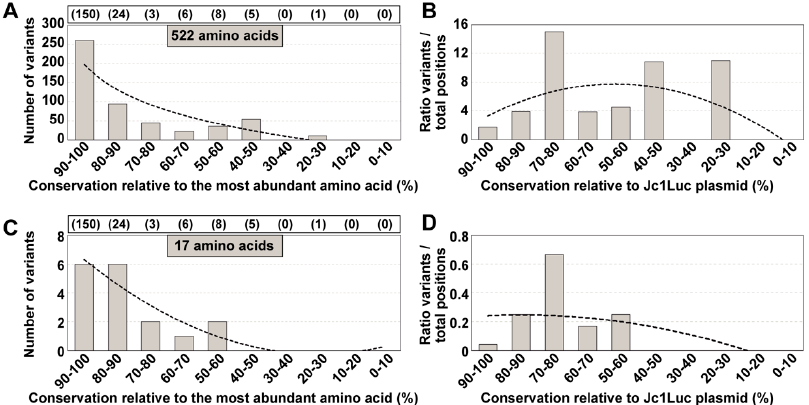
Figure 6. Distribution of positions with variant amino acids identified in HCV from infected patients among amino acid conservation groups according to the LANL amino acid sequence alignment. The residues under study span amino acid 124 to amino acid 320 of protein NS5B (which correspond to genomic nucleotides 7971 to 8561; H77 numbering). ( A ) Assignment of amino acid position